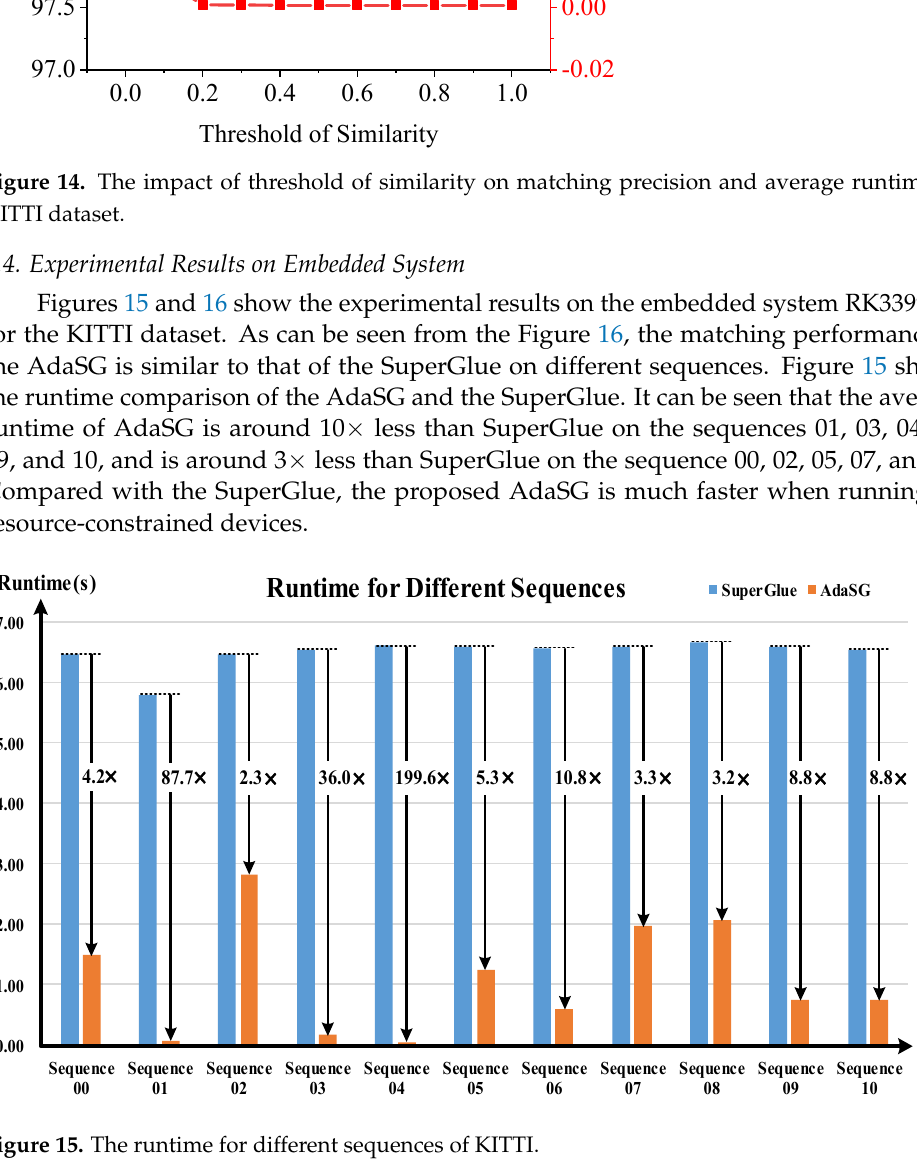
Figure 14. The impact of threshold of similarity on matching precision and average runtime on KITTI dataset.